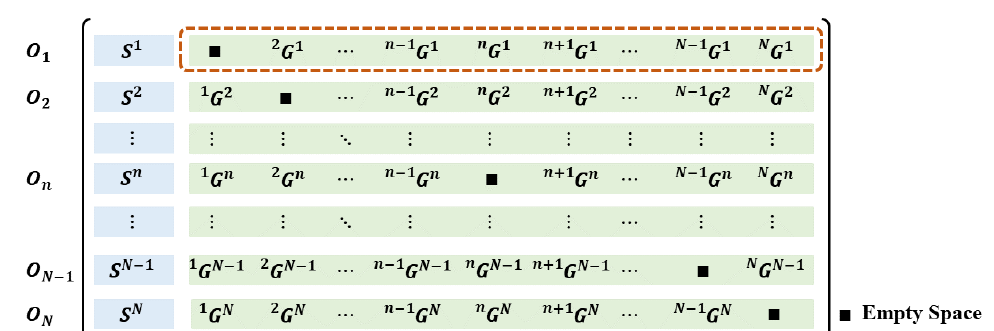
Figure 4. The SGD of a frame F : each row element in the SGD is the SGDU of object O i . The first element in an SGDU describes the semantic category of O i , and the other elements in SGDU depict the spatial relationship of O i with respect to the other objects.